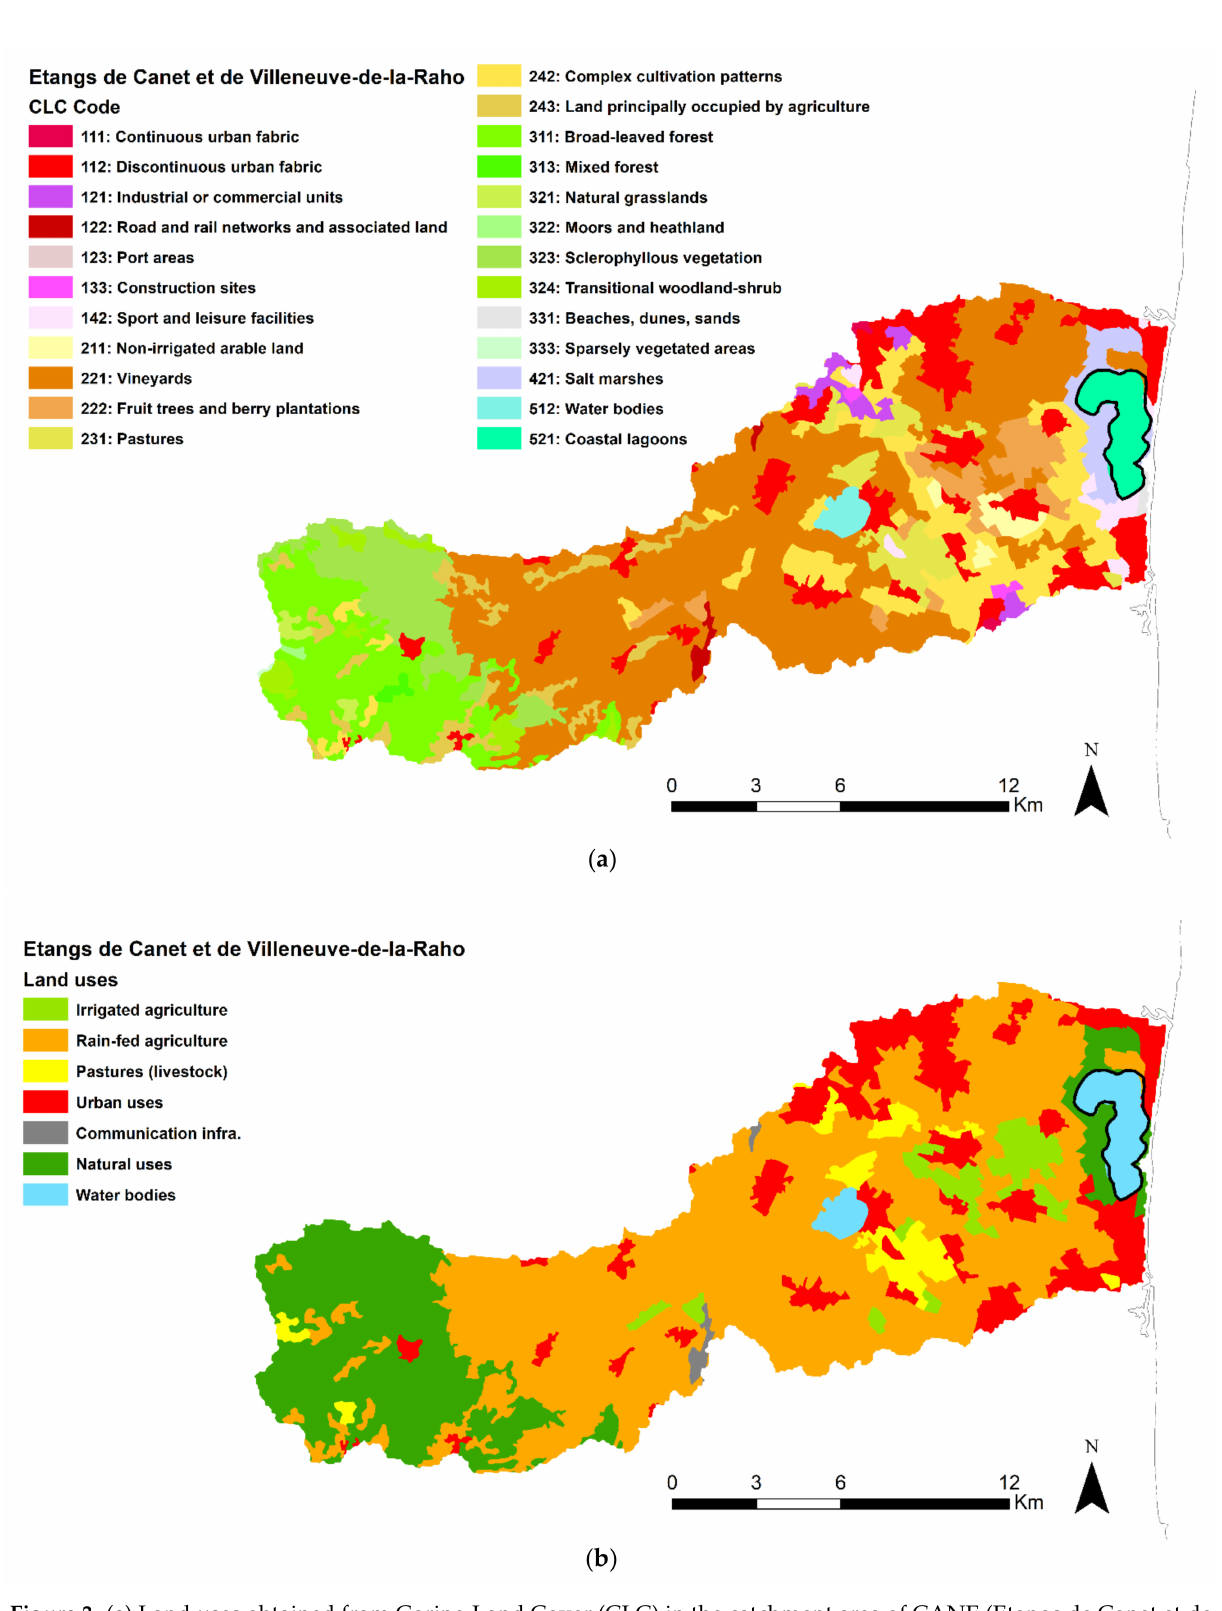
Figure 3. ( a ) Land uses obtained from Corine-Land Cover (CLC) in the catchment area of CANE (Etangs de Canet et de Villeneuve-de-la-Raho waterbody) (taken as an example). ( b ) Land uses joined by the land use groups established for the LUPLES (Land Uses for estimating Pressure Levels to approach the Ecological Status) method. Dumps and mining do not appear because their coverage is not relevant in the catchment of this